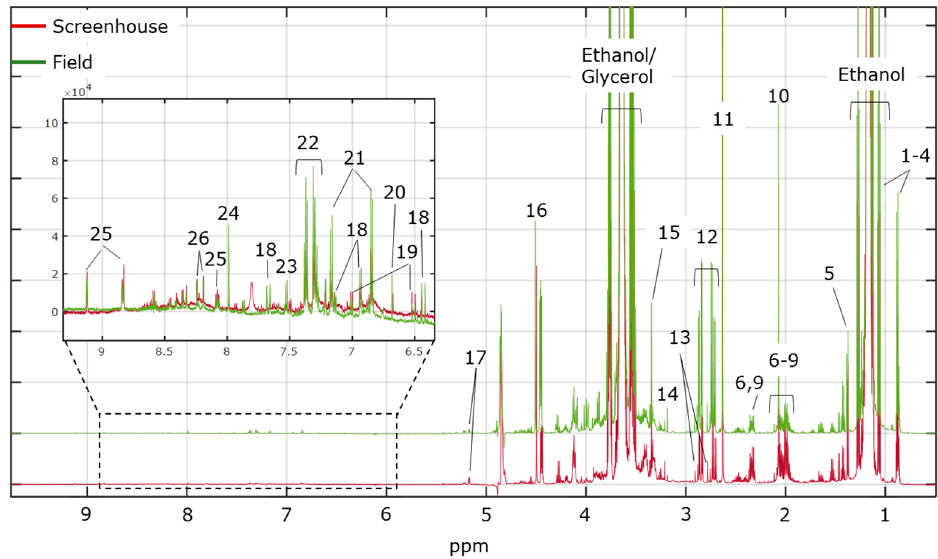
Figure 3. Representative 1 H NMR spectra of wine samples from the screenhouse and field experi- ments. Keys: 1. isoamyl alcohol (isopentanol); 2. isobutanol; 3. butyrate; 4. 2,3-butanediol; 5. lactate; 6. glutamate; 7. glutamine; 8. methionine; 9. proline; 10. acetate; 11. succinate; 12. malate; 13. citrate;